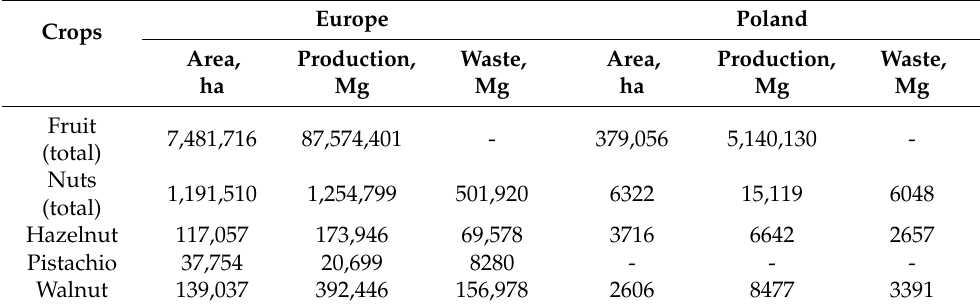
Table 1. Harvested area, fruit production, and nut waste generation in Europe and Poland